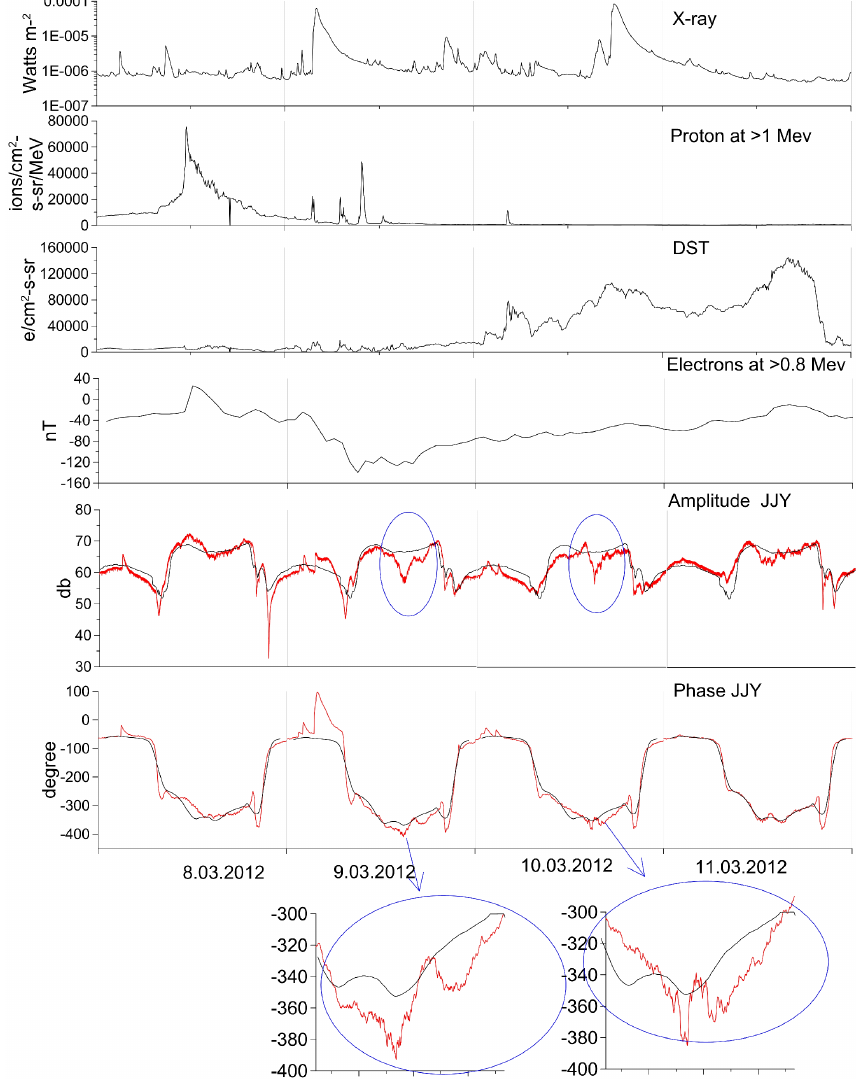
Figure 3. An example of the anomalies observed at the amplitude and phase of the JJY (40kHz) signal recorded in the PTK station during the magnetic storm on 9 March 2012. Three top panels show X-ray, outer-zone protons and electrons (GOES the satellite), and the next panel shows Dst index magnetic activity. In the two bottom panels, the amplitude and phase of the LF signal is shown. Red and black lines are the observed and monthly averaged signals, respectively. The circles highlight the anomalies in the amplitude and phase related to the magnetic